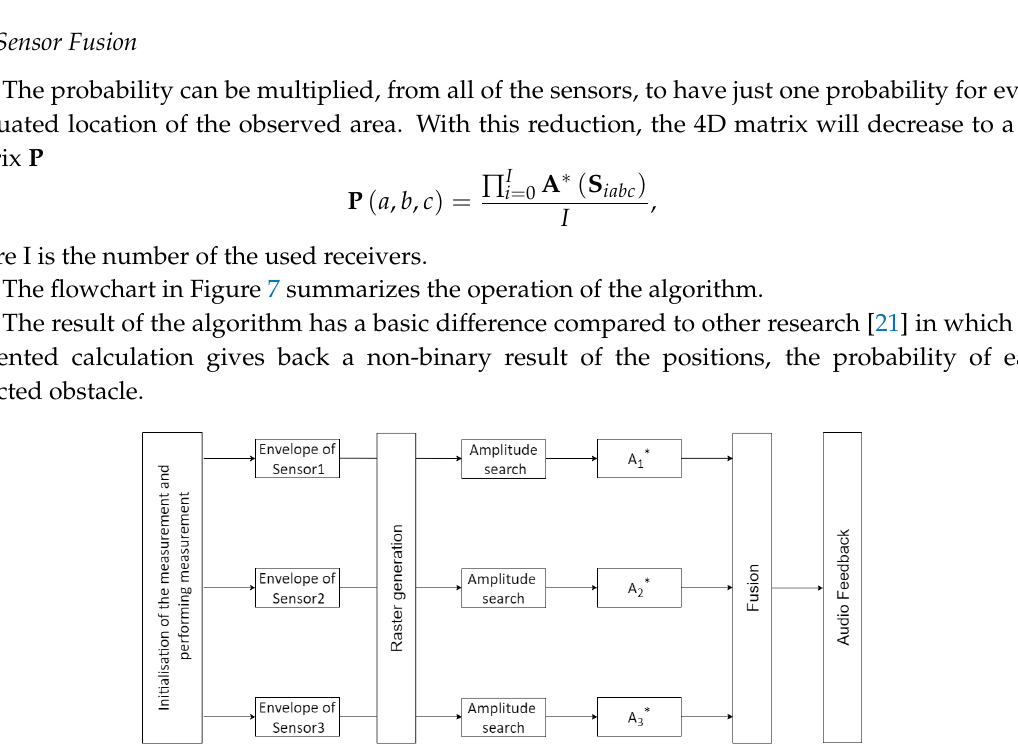
Figure 7. The flow chart of the